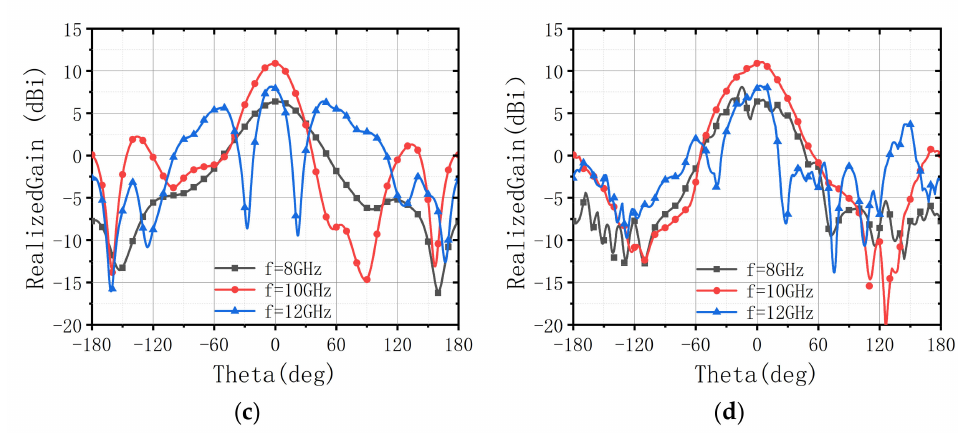
Figure 6. ( a ) The port reflection parameters of the array. ( b ) Port isolation parameters of the array. ( c ) E-plane pattern of the first element. ( d ) H-plane pattern of the first